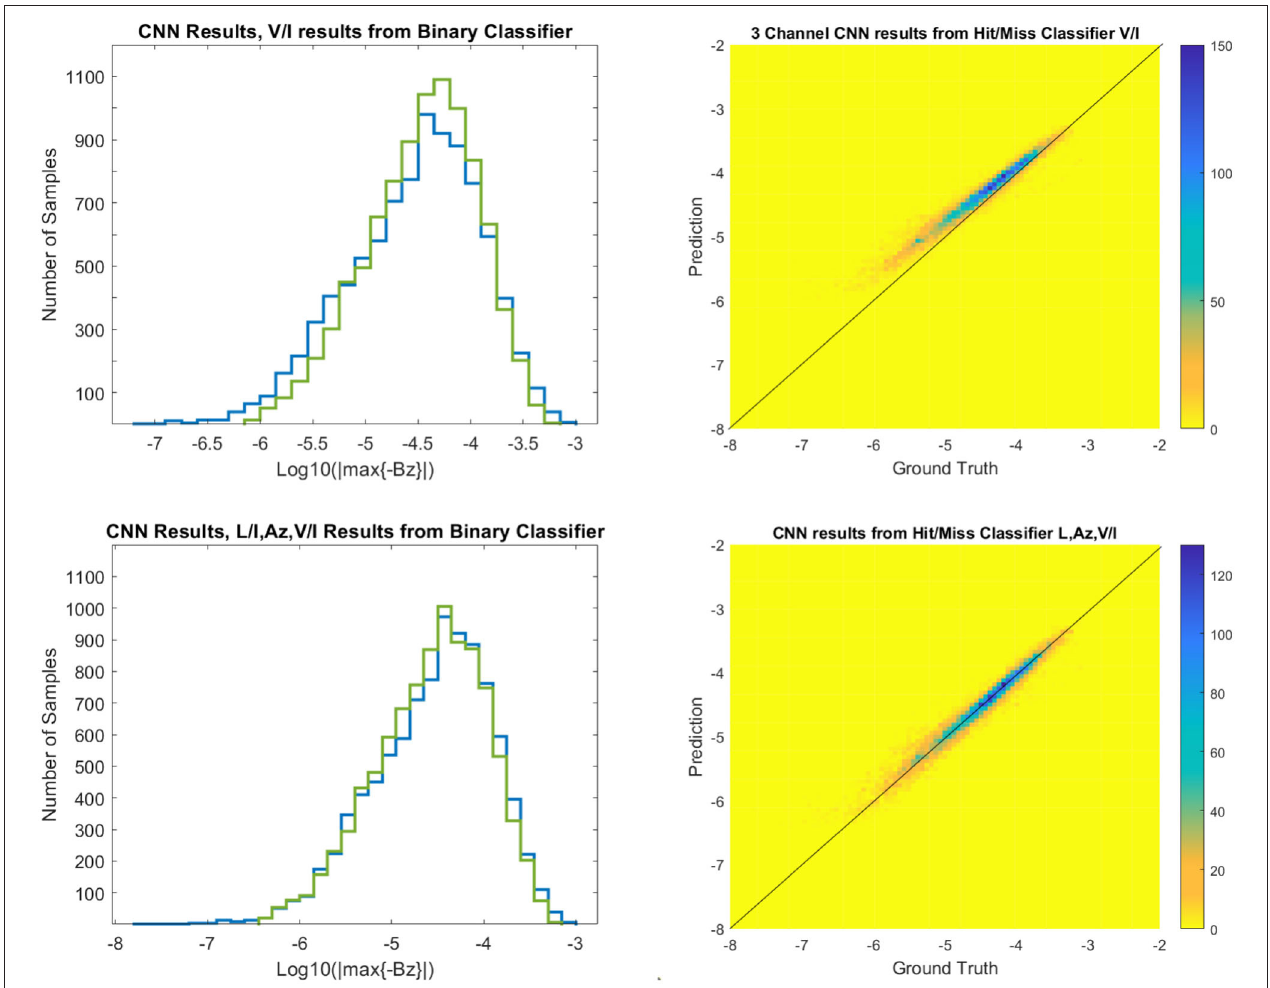
FIGURE 14 | Two representations, histogram and scatter plot, of predictions of CNN 2 vs. ground truth, on the subset of events which FNN 2 has predicted was a “storm.” Top : when using only circularly polarized light, V / I , as input to FNN 2 . Bottom : when using both linearly and circularly polarized light, ( L / I , Az , V / I ), as input to FNN 2 . The color bar indicates the number of samples. Blue lines are ground truth in both histograms. The axes in the scatter plot are that of log 10 { max {− B z }} , and in all panels the units of max {− B z } are G.